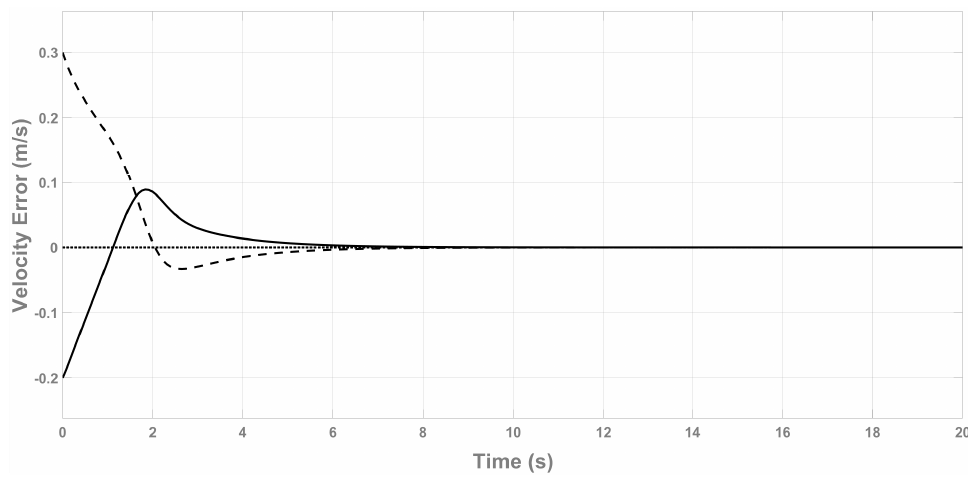
Figure 2. Velocity observer error ˜ V b . ˜ u (continuous line), ˜ v (dashed line), ˜ w (dotted line).